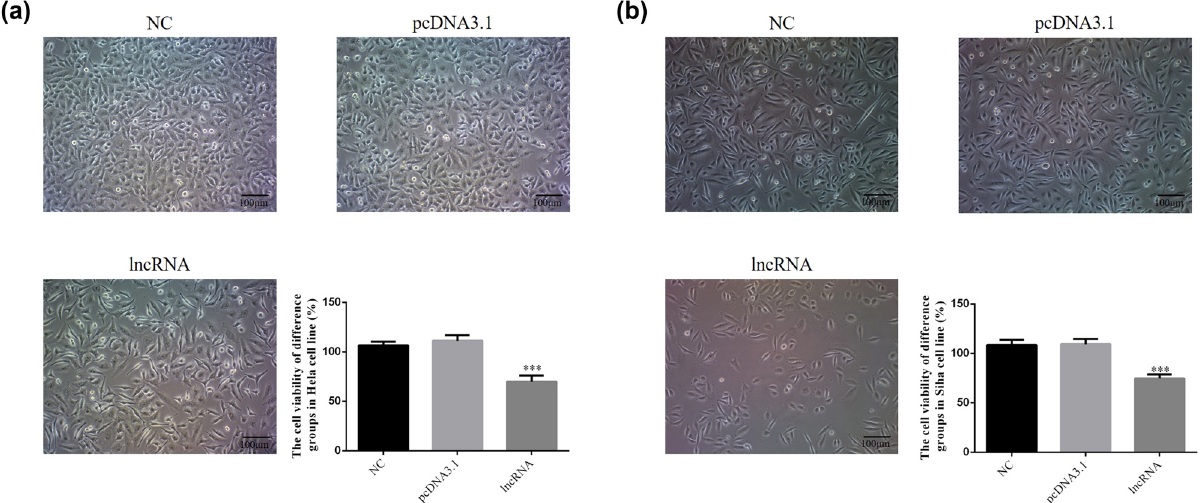
Figure 2: The cell viability of di ff erence groups by CCK - 8 in HeLa and SiHa cell lines. NC: normal control group; pcDNA 3.1: the cells were transfected with pcDNA3.1; lncRNA: the cells were transfected with UBE2R2 - AS1 by pcDNA3.1. ( a ) The cell viability of di ff erence groups by CCK - 8 in HeLa cell. *** P < 0.001, compared with NC group. ( b ) The cell viability of di ff erence groups by CCK - 8 in SiHa cell. *** P < 0.001, compared with NC